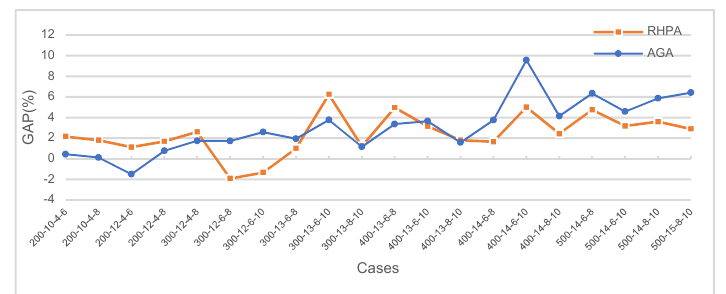
Figure 10. The curve of GAP value under different arithmetic cases.